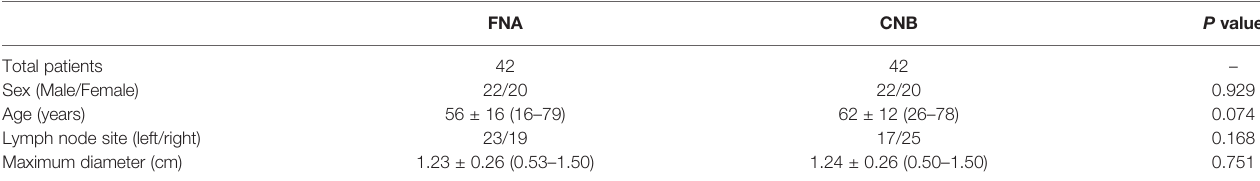
TABLE 1 | Basic information of the patients in the FNA and CNB